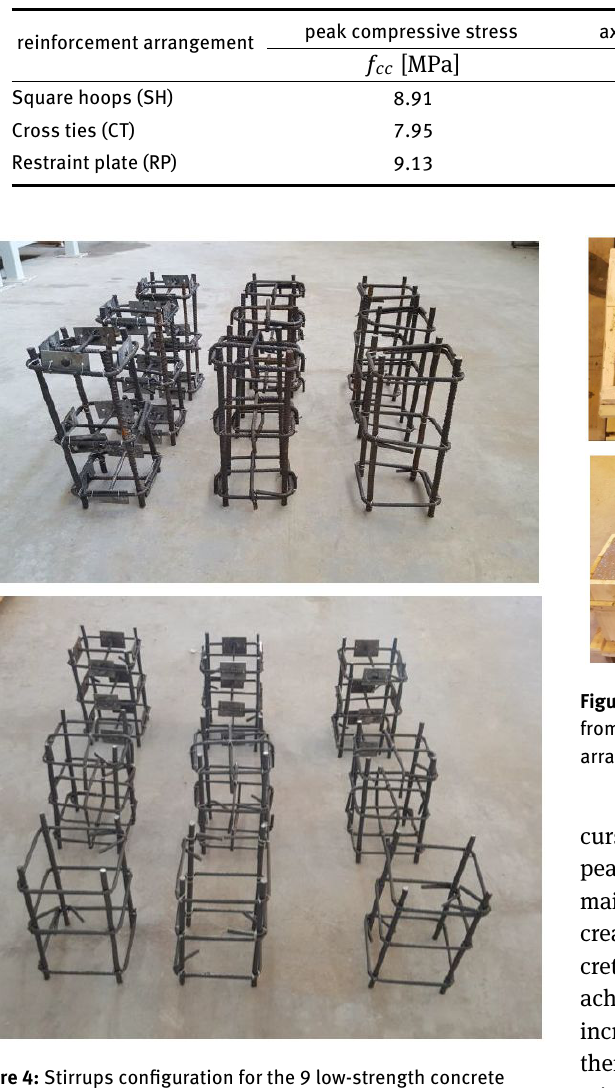
Figure 4: Stirrups configuration for the 9 low-strength concrete columns (top) and for the 9 medium-strength concrete columns (bottom)